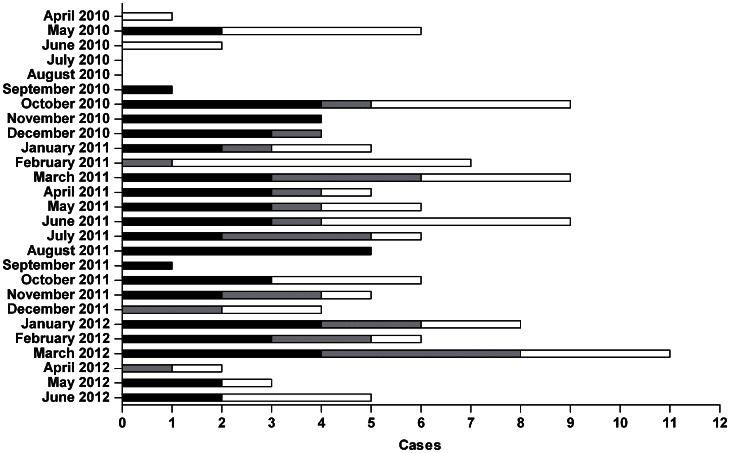
Identification of BU cases in the Mapé Basin following the survey.In the 27 months following the exhaustive survey all clinically diagnosed BU cases in the Bankim area were included in a cohort study. Cases are separated into the RT-PCR confirmed cases which occurred inside (black) and outside (grey) of the Bankim HD. RT-PCR negative and non-laboratory examined cases occurring anywhere in the Mapé basin during the same time period are also shown (white).